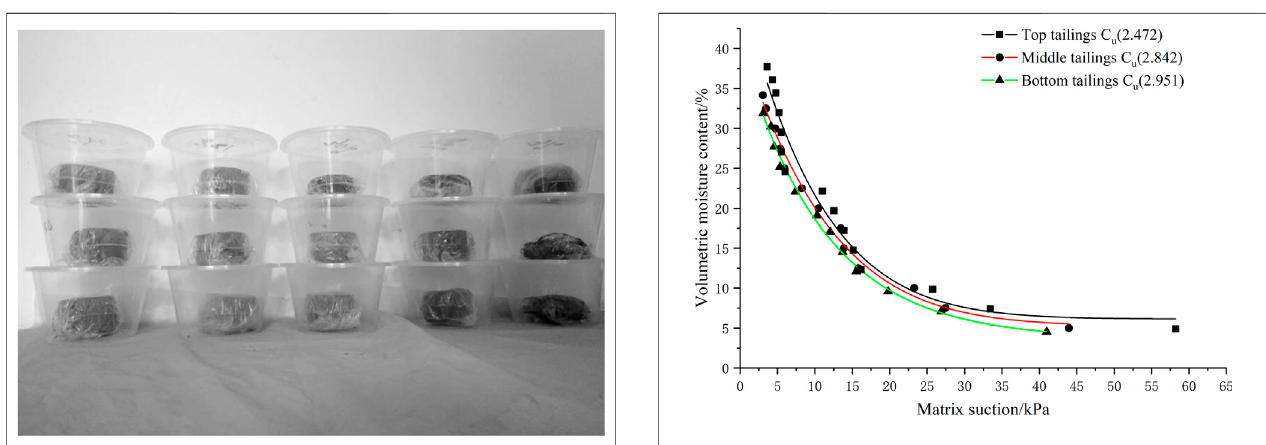
FIGURE 5 | The experimental data and best- fi t SWCC of tailings at different